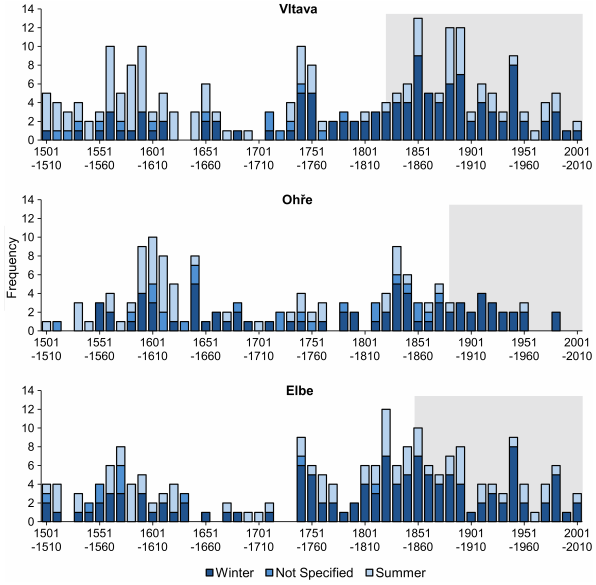
Figure 5. Decadal frequencies of floods for Bohemia (the Czech Republic) from 1501–2010 stratified by season (winter, November– April; summer, May–October): the River Vltava (from ˇCeské Budˇejovice to its confluence with the Elbe), the River Ohˇre (from Kadaˇn to its confluence with the Elbe), the River Elbe (from Brandýs to Dˇeˇcín). Grey shaded areas mark the instrumental pe- riod, for which discharges larger than the 2-year flood are counted, for the pre-instrumental period floods mentioned in the documen- tary sources are counted (modified from Brázdil et al.,